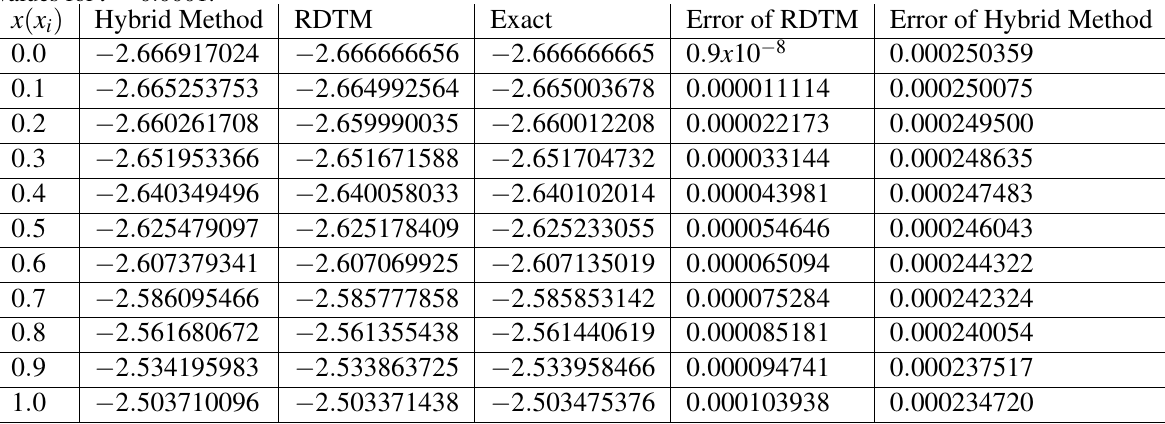
Table 4 Comparison of the approximate solutions (hybrid method and RDTM) with exact solution u ( x , t ) and the error values for t = 0 .